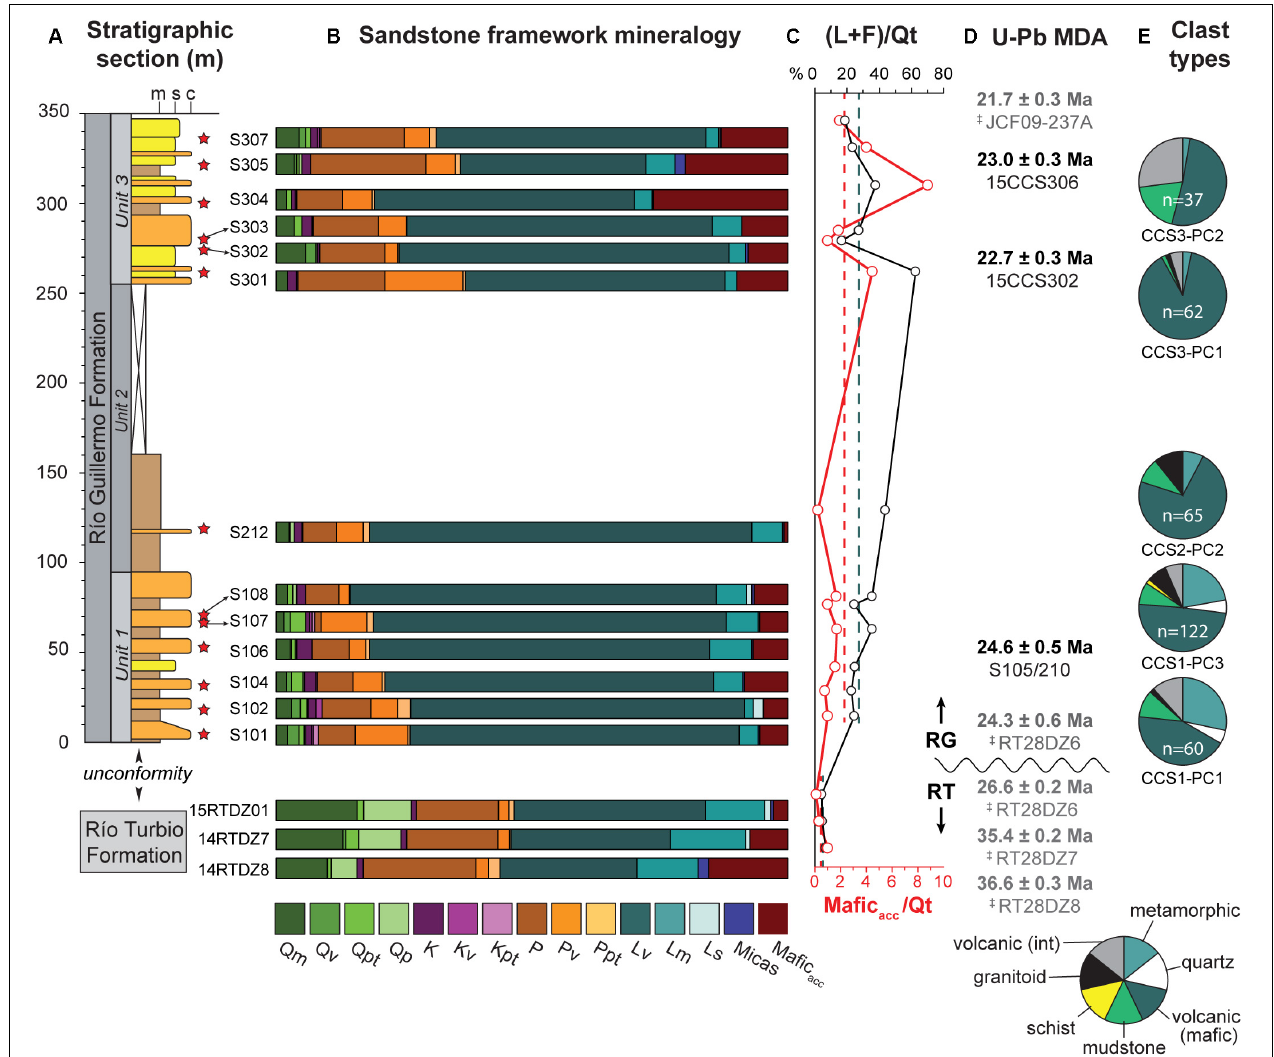
FIGURE 5 | Summary of modal sandstone petrography, clast compositions, and MDA from the Río Guillermo Formation at Cancha Carrera. Data from the underlying upper Río Turbio Formation are shown for comparison (stratigraphic positions approximated). (A) Simplified stratigraphic column. (B) Sandstone framework mineralogy. See Table 4 caption for mineralogic abbreviations and section “Upper Oligocene-Lower Miocene Tectonics and Sedimentation History” for detailed discussion of trends. (C) (L + F)/Qt and Mafic acc /Qt plots show relative immaturity (in %) of Río Guillermo Formation vs. upper Río Turbio Formation Dashed line represents the average of data for respective formations. (D) Relative contributions of clasts shown approximately in stratigraphic position – see Figure 3 for sample locations. (E) Maximum depositional ages (MDA) interpreted from detrital zircon U-Pb geochronology. For comparison, ‡ denotes samples from Fosdick et al.